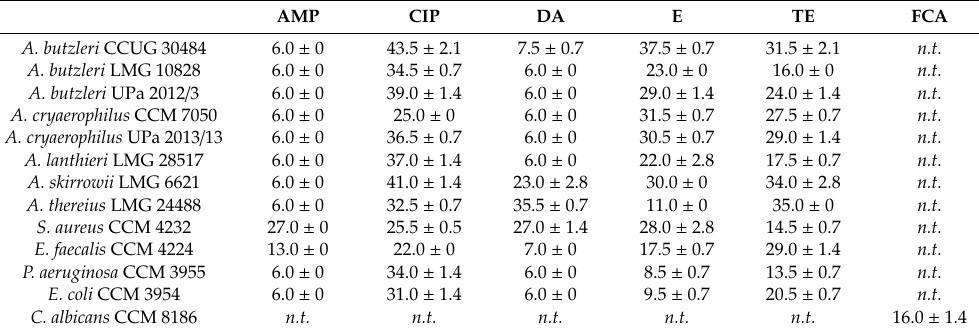
Table 8. Testing the e ff ectiveness of antibiotics and antifungals (mean inhibition zones in mm, including disc 6 mm in diameter ± standard deviation), n =